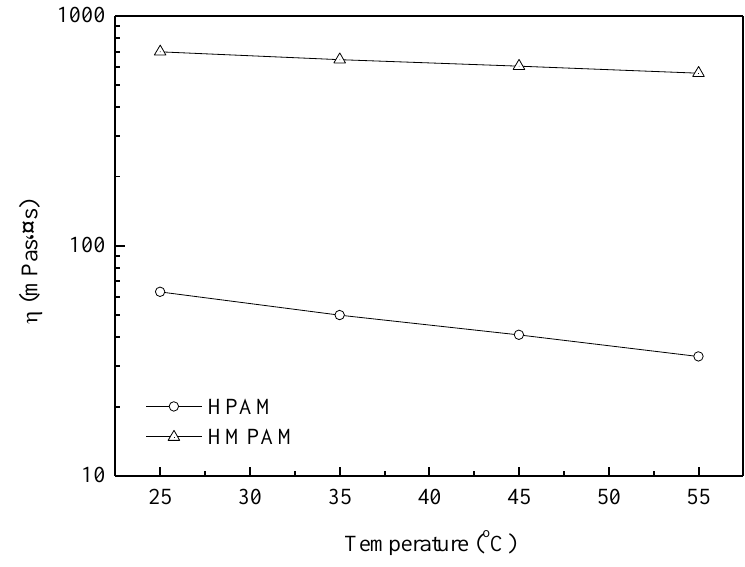
Figure 4. The apparent viscosity of polymer solutions with 1500 mg/L versus temperature at 45 °C. As shown in Figure 5, both polymer solutions exhibited a Newtonian plateau at low shear rates and shear thinning behavior at higher shear rates. For HMPAM solutions, the viscosity finally tended to be constant at high shear rates as a result of the balance between intermolecular association and disassociation. These results indicate that HMPAM has a perfect shear tolerance at high shear rates.